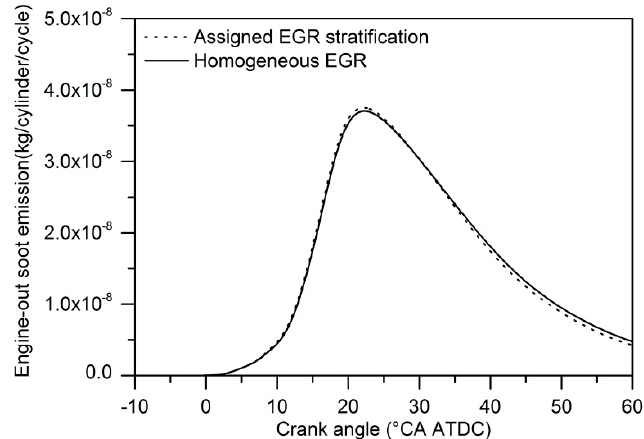
Figure 10. Comparison of engine-out soot history between uniform EGR and assigned EGR stratification with equal mass of EGR in cylinder.